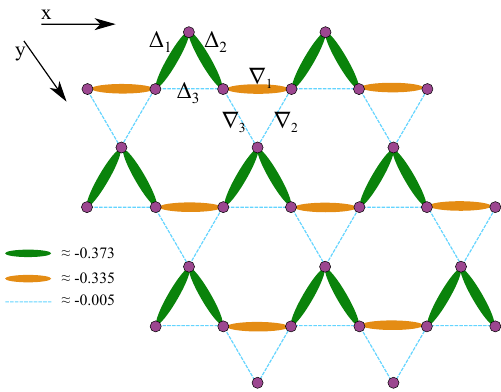
Figure 6: (Color online) The lattice-nematic pattern in the large breathing anisotropy limit at J (cid:53) / J (cid:52) = 0.01 constructed from strong and weak correlations on the links of the upward and downward kagome triangles which breaks the C symmetry of the system while preserving the translational invariance in every direc- tion on the lattice. The correlations reported in the figure are obtained with PESS D = 13. The values on the green links are the average correlation of the two edges (see the text for further